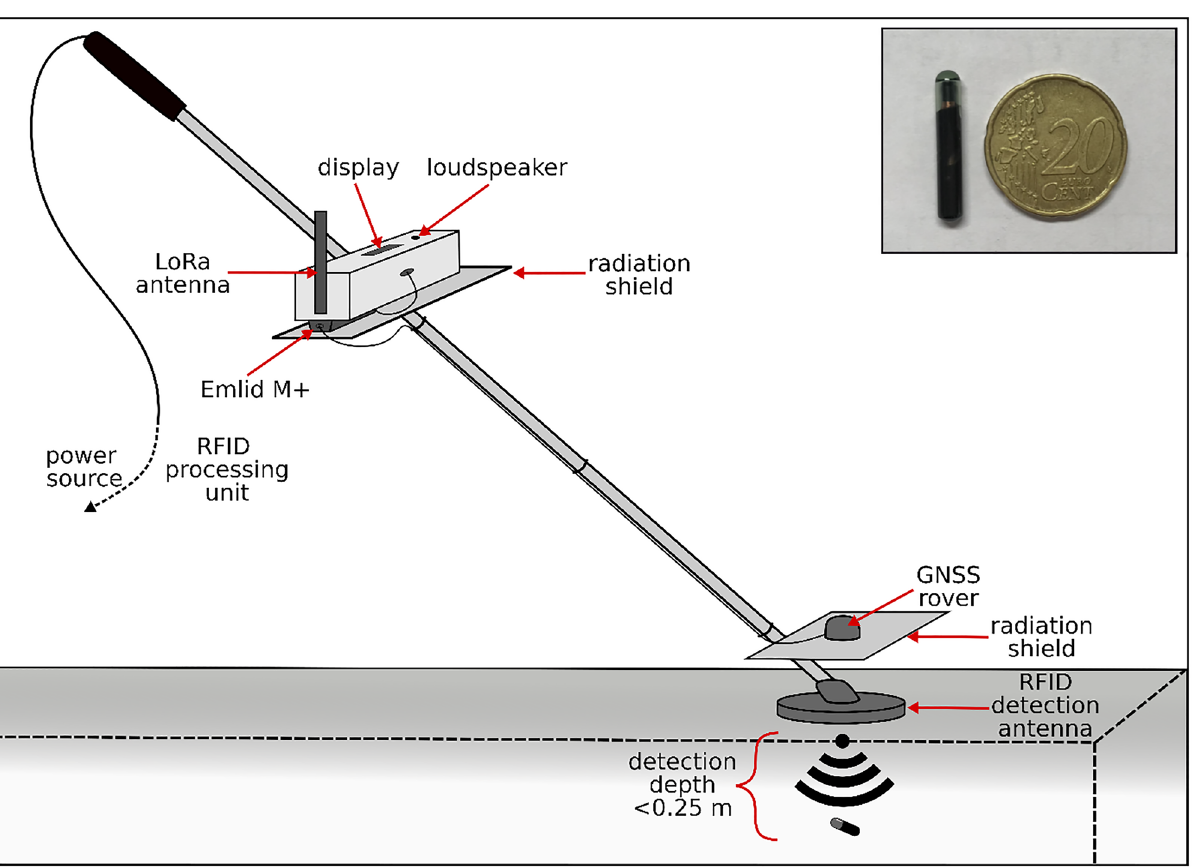
Figure 3. Schematic drawing of the RTK GNSS RFID (real time kinetic global navigation satellite system radio- frequency identification) detection and geolocation system. The lower part (direct proximity to soil surface) of the setup consists of an RFID and GNSS antenna, which are located above each other. The upper part consists of the processing unit for RFID identification and RTK GNSS module that communicates with a geostationary base station (not shown) via long-range radio (LoRa) to receive correction data. The inset frame contains a photo of an RFID tag next to a coin acting as